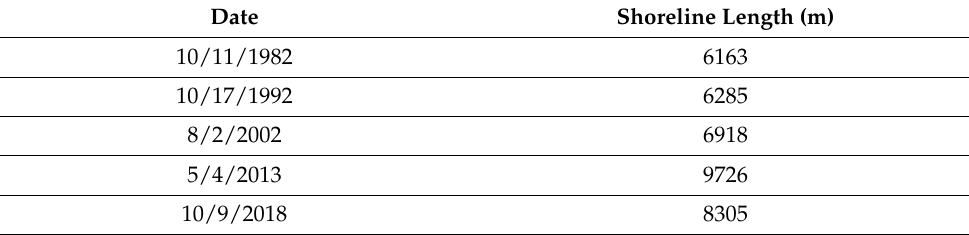
Table 10. Shoreline length data of Segment G.